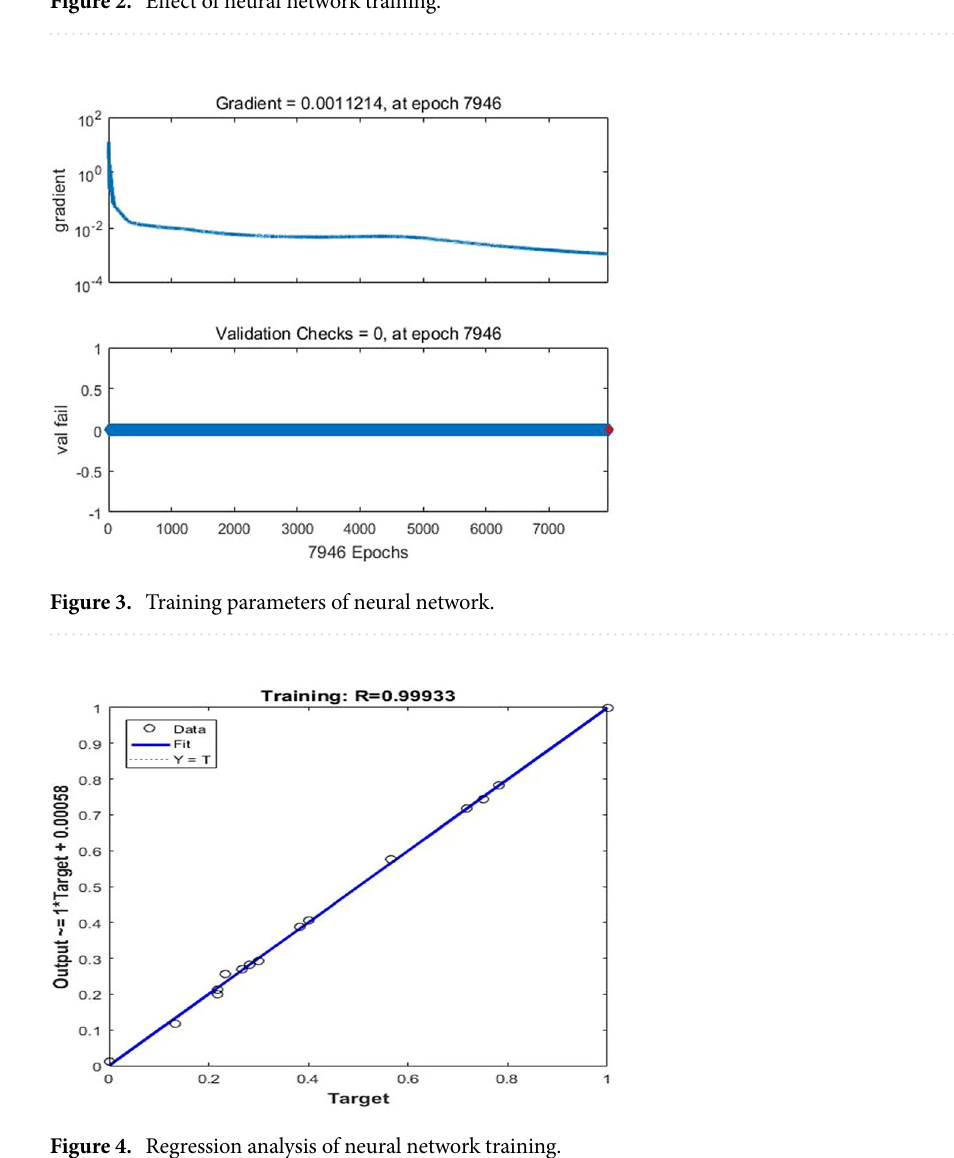
Figure 2. Effect of neural network training.